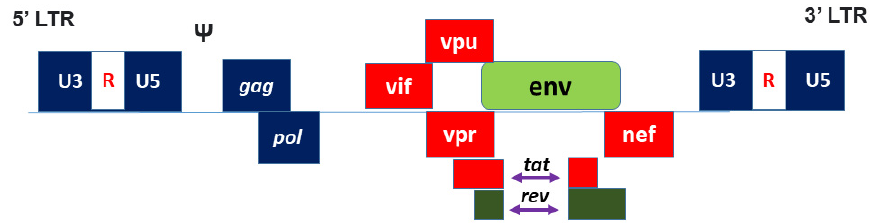
Figure 1. The HIV-1 virus contains three gene regions, gag , pol , and env , along with accessory genes (vif , vpr , vpu , nef ), regulatory genes ( tat , rev ), and the 5 ′ and 3 ′ flanking long terminal repeats (LTR). The psi ( Ψ ) element is located at the 5 ′ end of the HIV-1 genome just upstream of the gag initiation codon. Table 1. Functions of HIV-1 proteins.